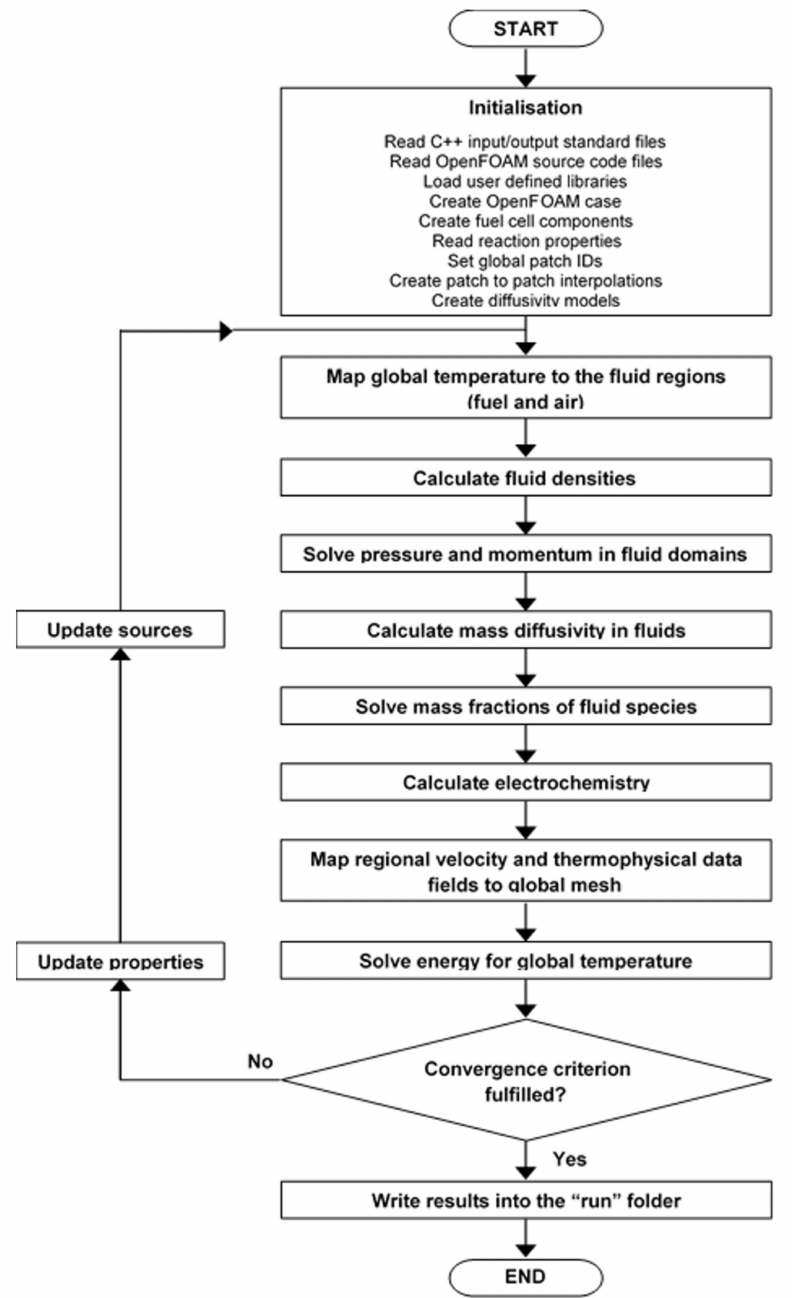
Figure 3. Flow diagram of the solution